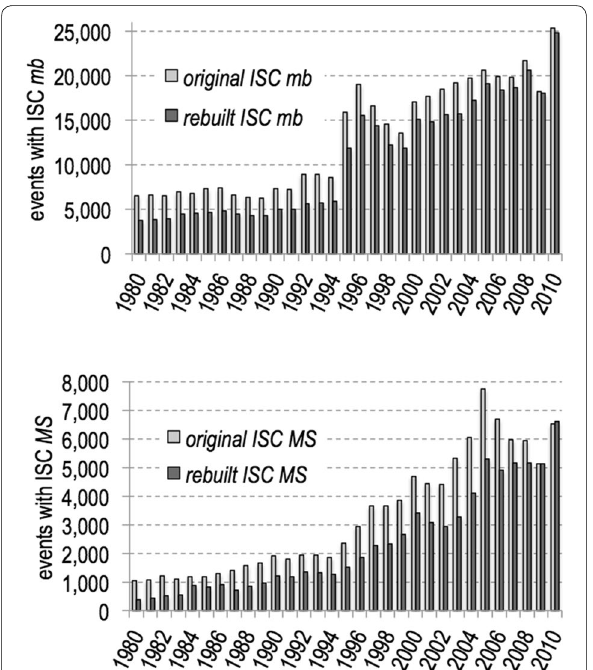
Fig. 8 ISC mb (top) and MS (bottom) magnitude frequency distributions of the original and rebuilt ISC Bulletins